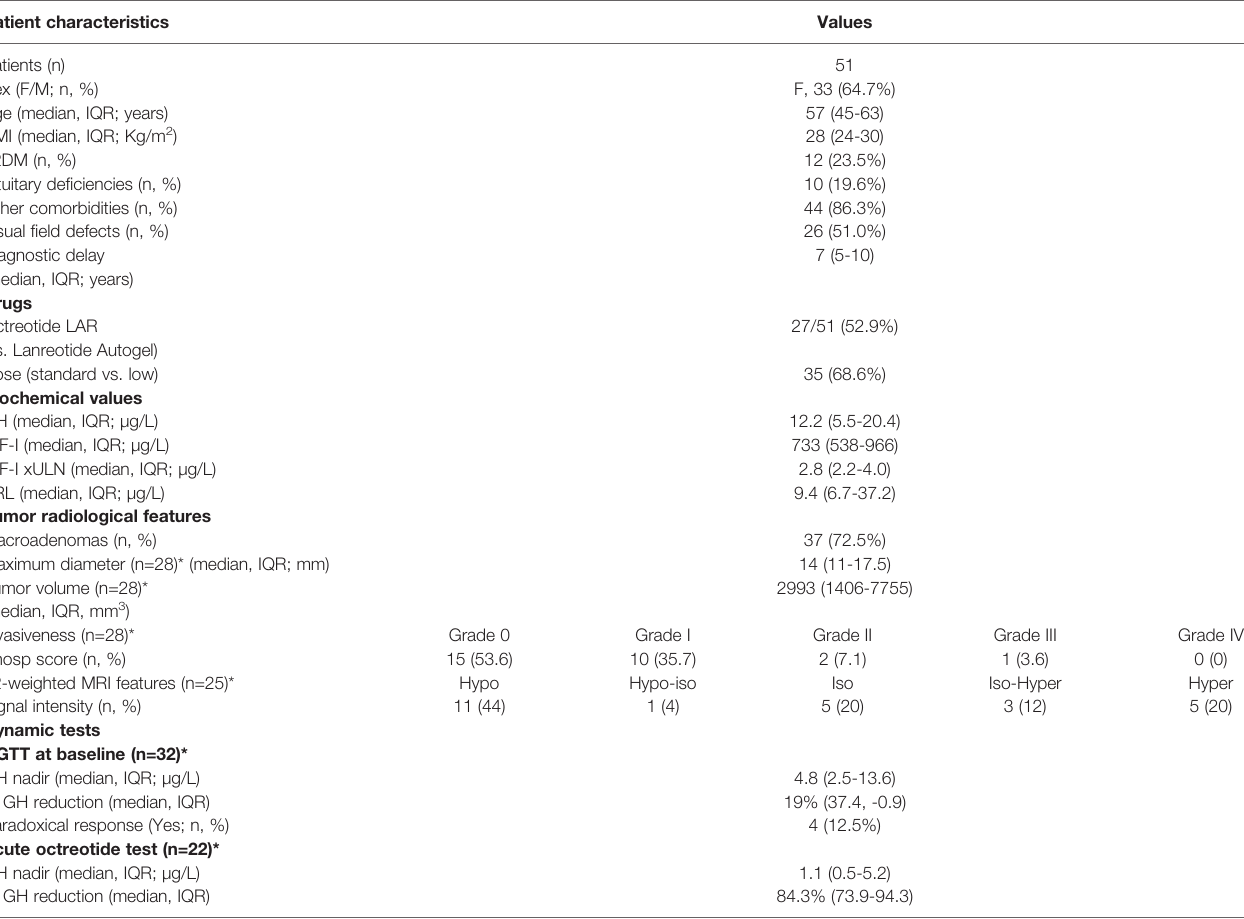
TABLE 1 | Detailed characteristics of the acromegaly patients included in the